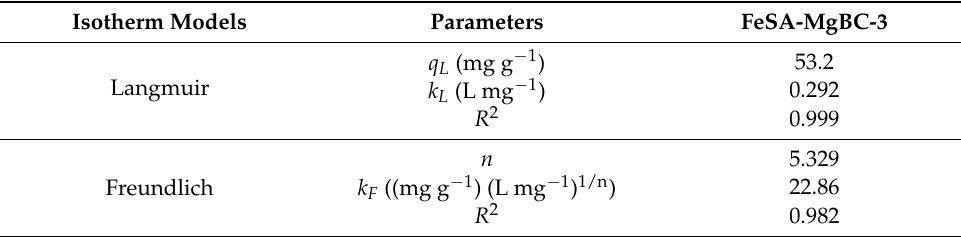
Table 3. Parameters of adsorption isotherm models in this study.